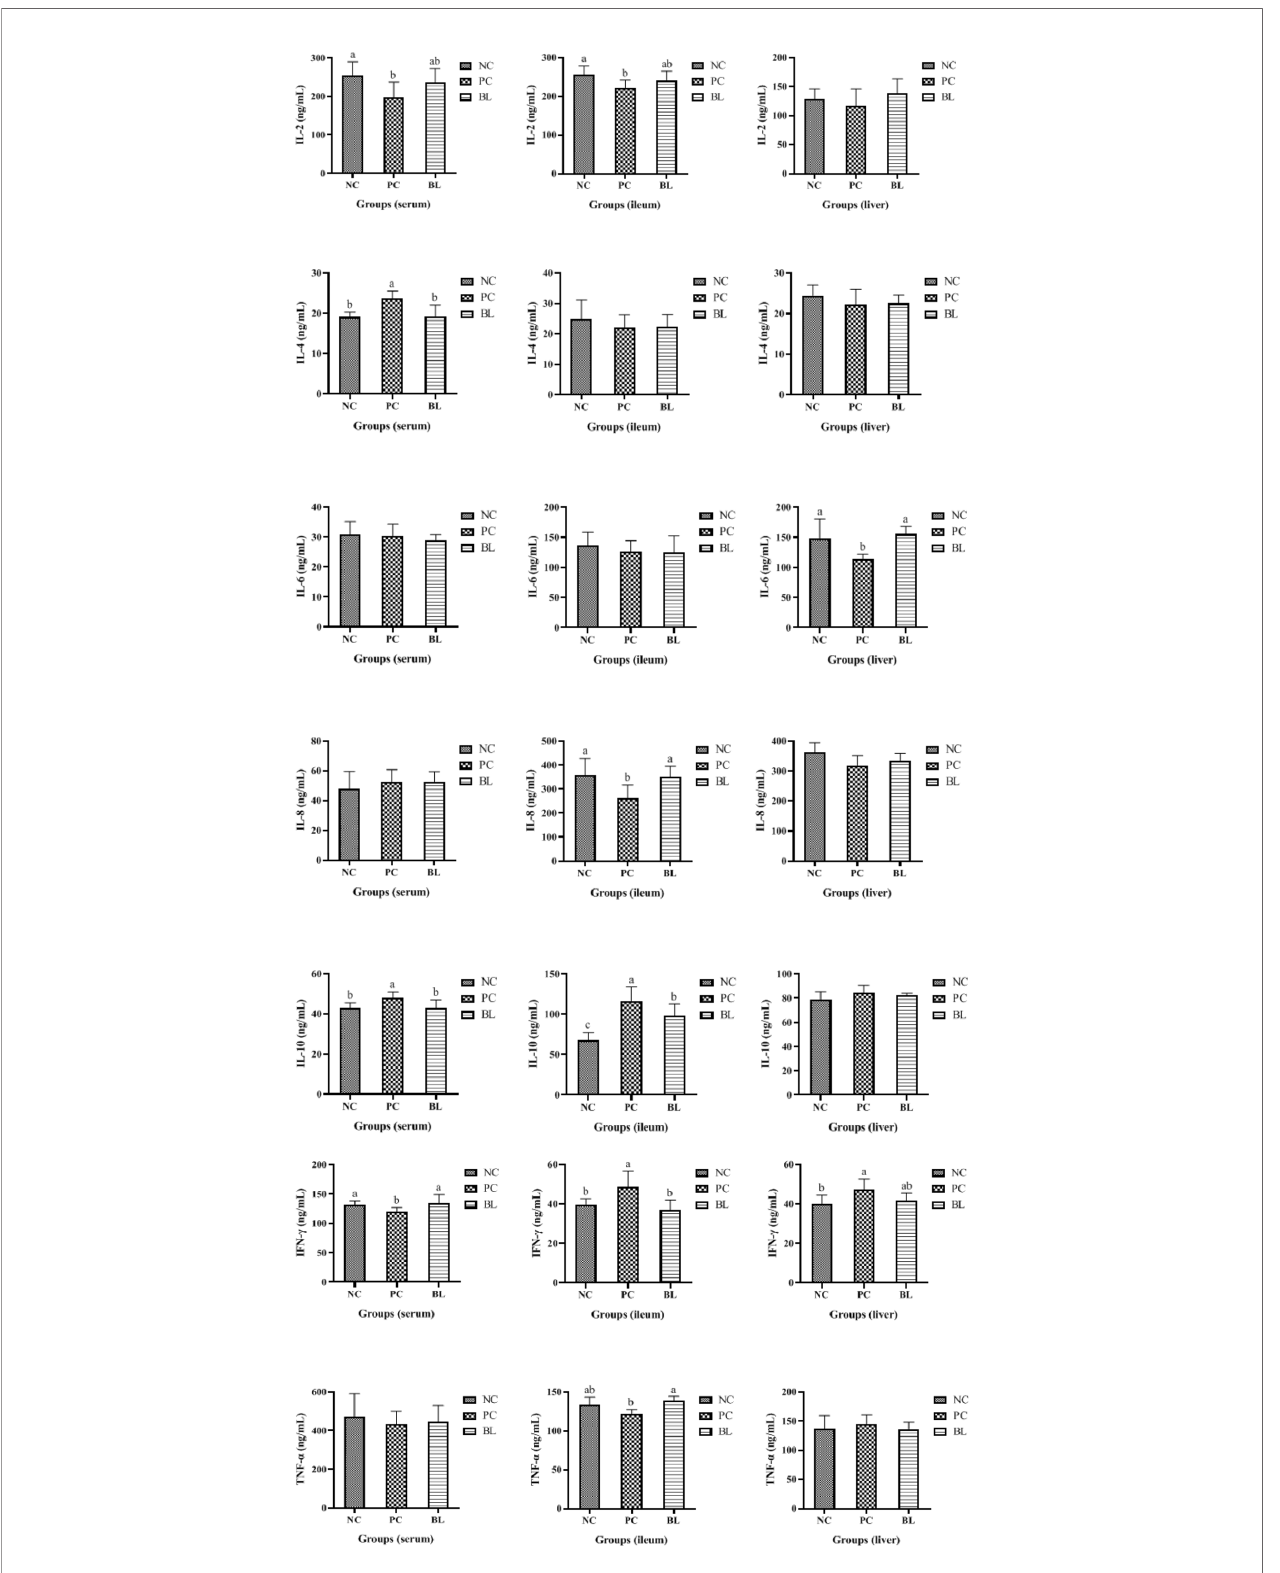
FIGURE 5 | Protein contents of IL-2, IL-4, IL-6, IL-8, IL-10, IL-17, IFN- g , and TNF- a were determined in the serum, ileum, and liver of broiler chickens (n = 6, mean with SD). a, b means those with different letters are signi fi cantly different ( P < 0.05). One-way ANOVA and adjustment for multiple comparisons were